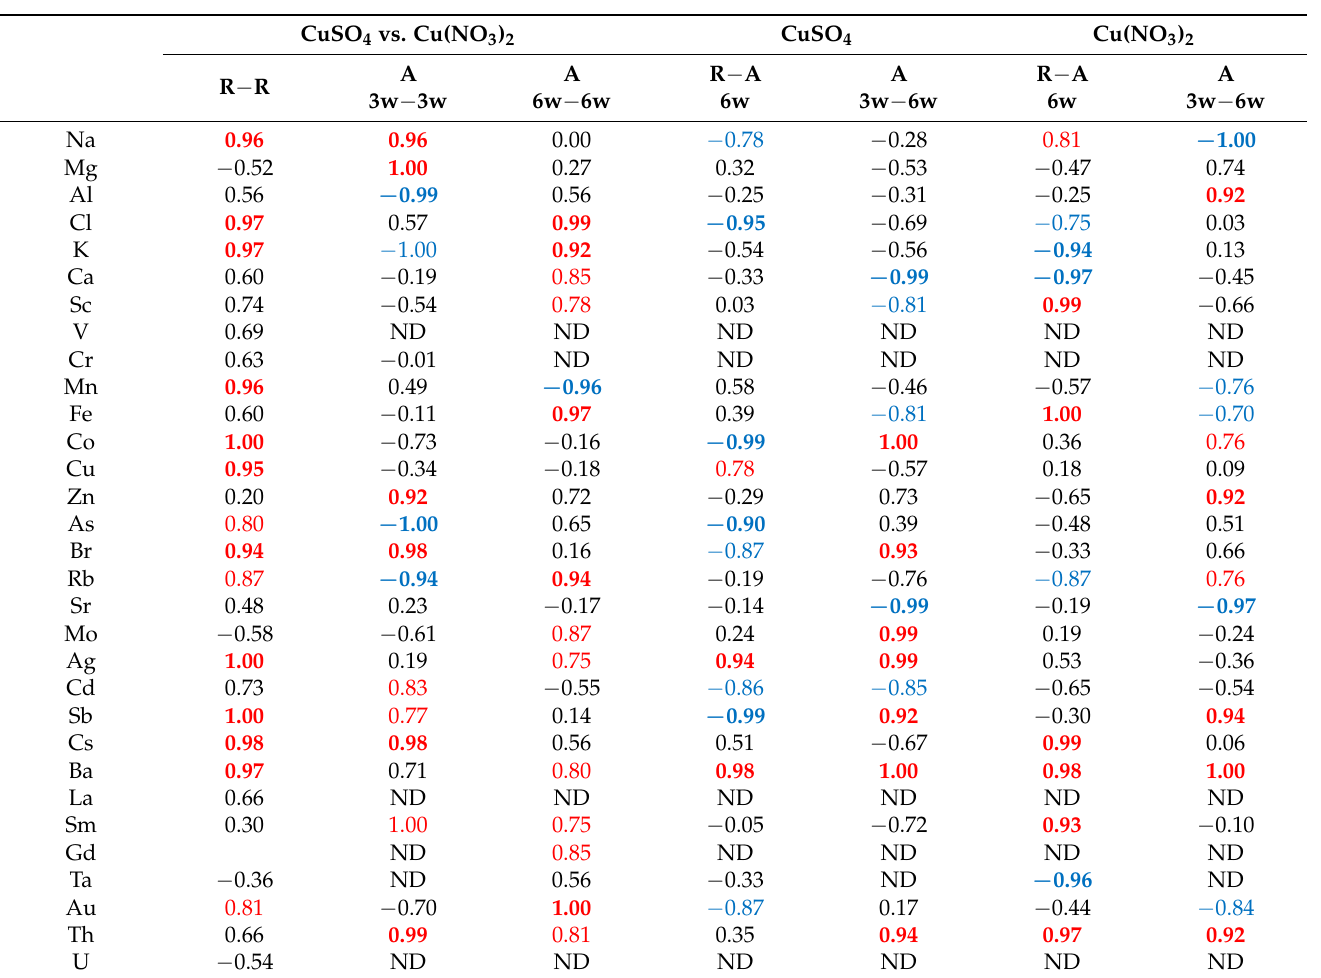
Table 2. Correlation of elemental content in various parts of wheat grown in soil with the addition of CuSO 4 and Cu(NO 3 ) 2